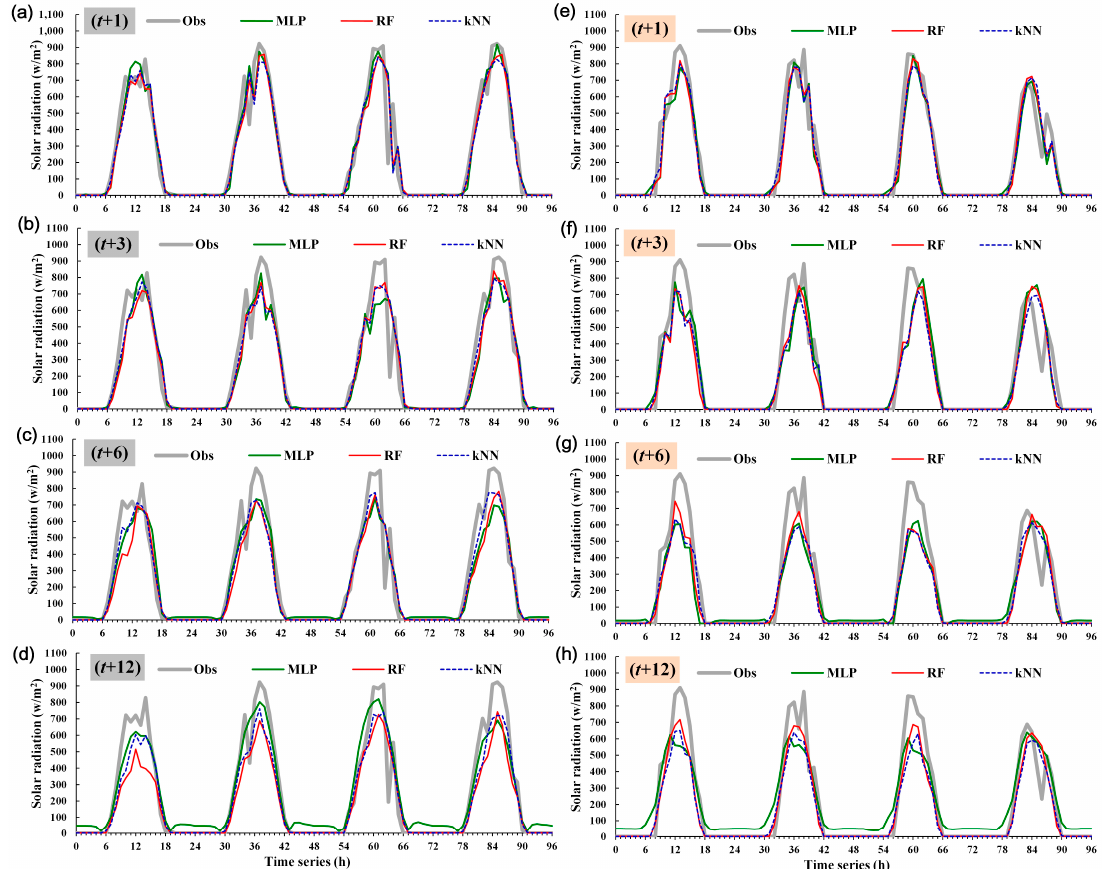
Figure 13. Hourly changes in the observed and predicted global irradiance with a β ′ of 23° for the four consecutive days starting from: ( a – d ) the summer solstice, and ( e – h ) the winter solstice.